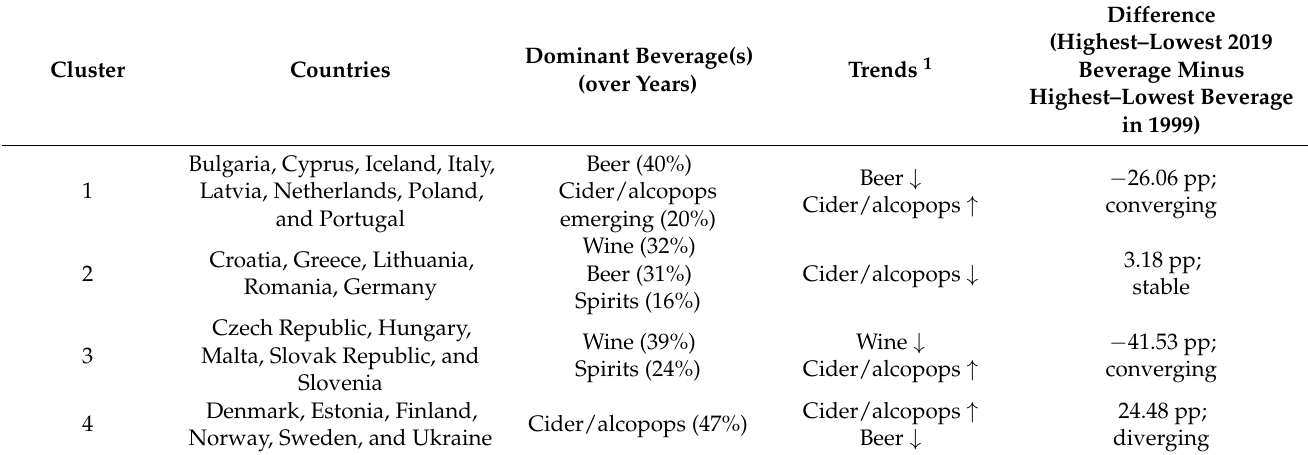
Figure 2. Clusters of trends in distribution of beverages consumed on most recent drinking occasions for boys. Table 1. Clusters by country, dominant beverage(s), trends, and difference between highest and lowest in 2019 and highest and lowest in 1999 for girls.